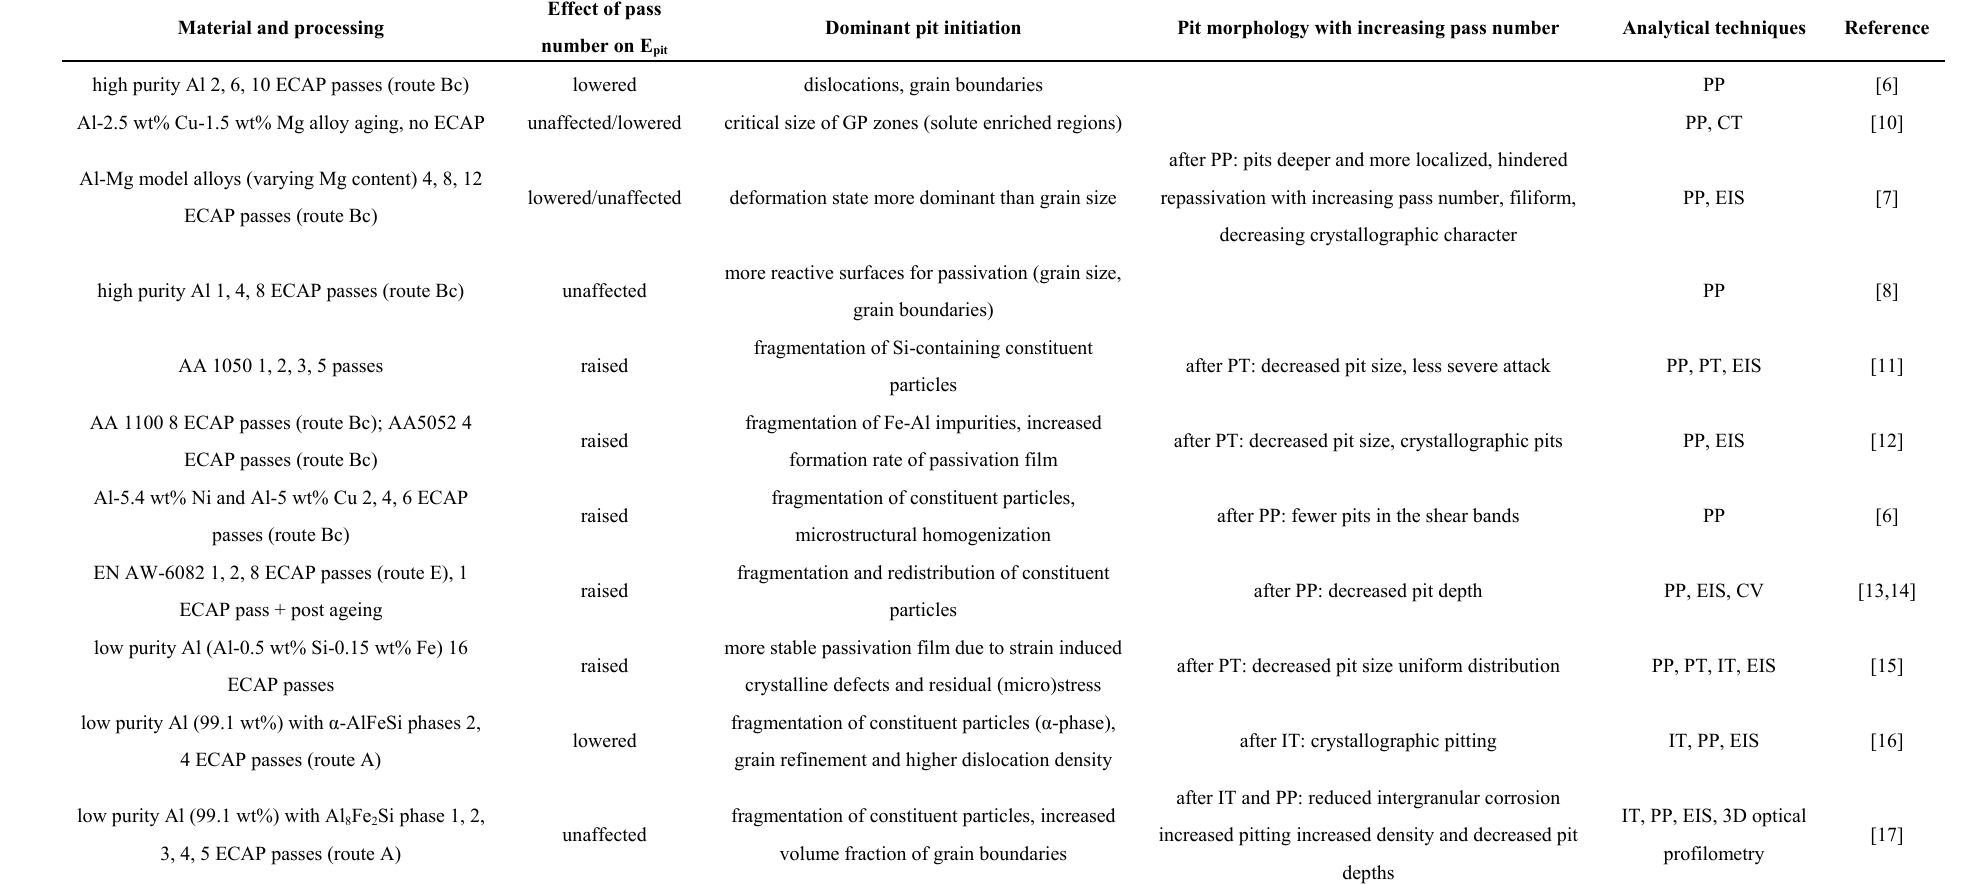
Table 1. Review of pitting corrosion results published for Al and its